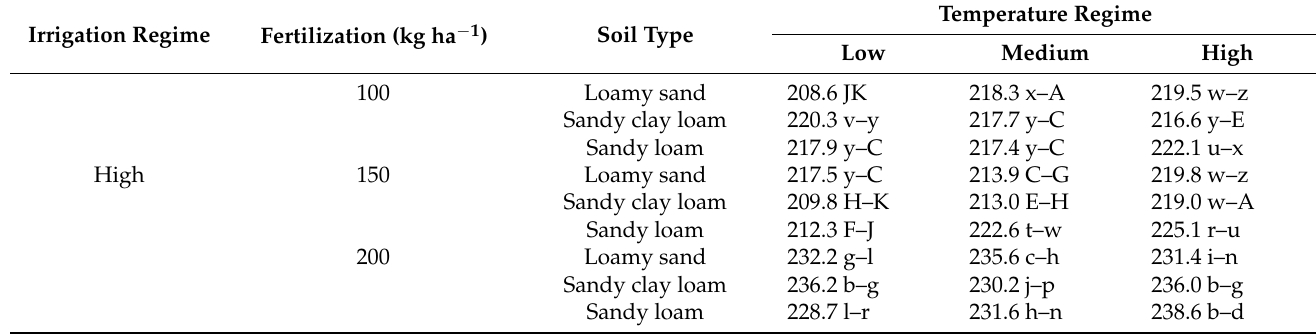
Table 7. Interactive effect of air temperature and irrigation regimes, nitrogen fertilizer application, and soil type on leaf area (cm 2